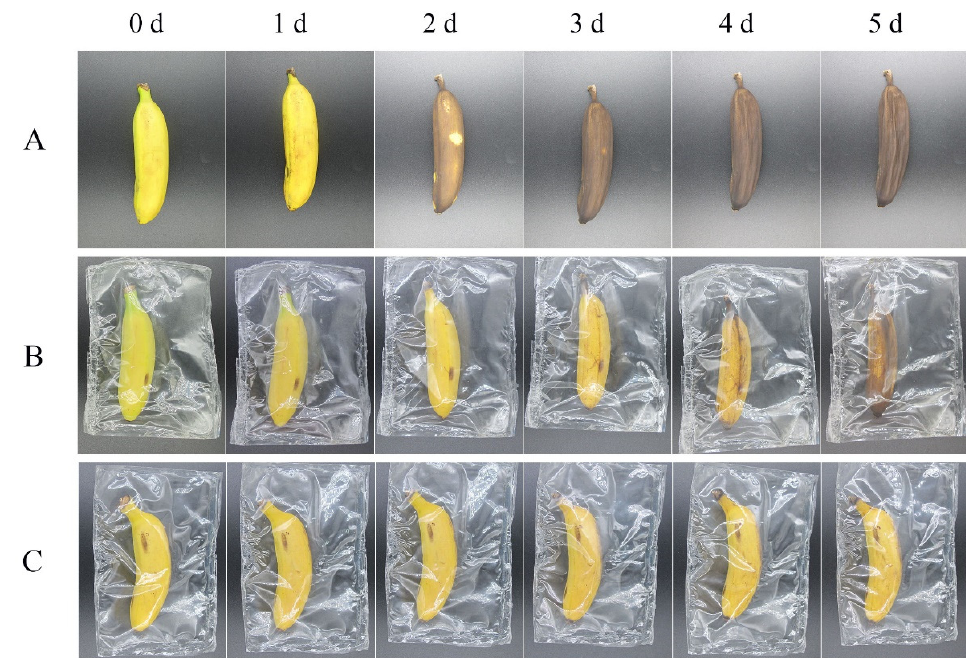
Figure 10. CA-loaded composite NPs for banana storage. (( A ) storage in air; ( B ) storage in PVA film; ( C ) storage in PVA film containing 5 wt% CA-loaded composite NPs). ( C ) storage in PVA film containing 5 wt% CA-loaded composite